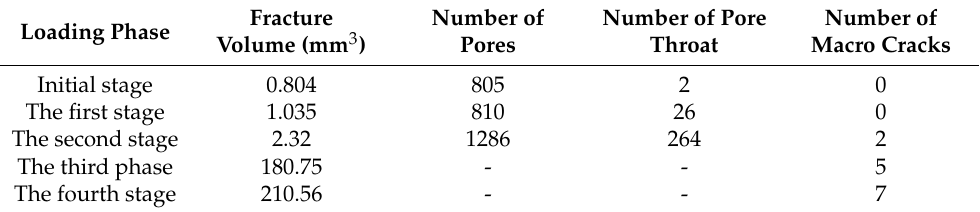
Table 2. Fracture development parameters of mudstone at different loading